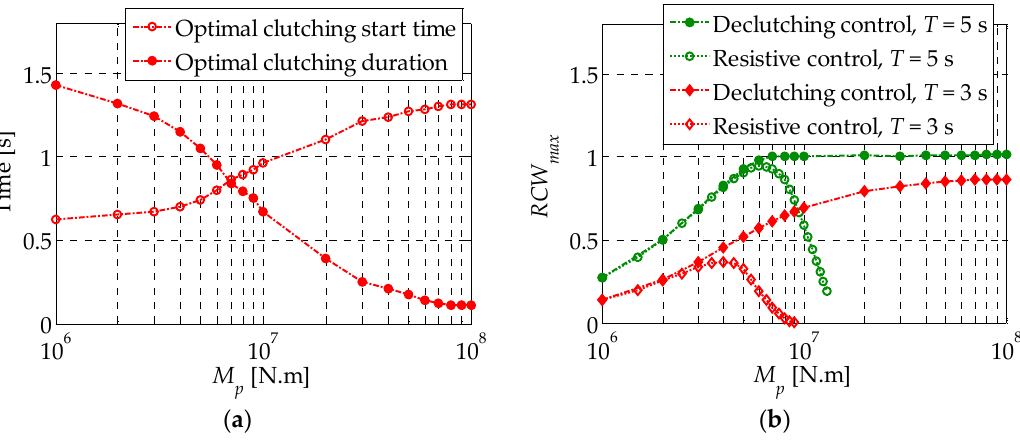
Figure 12. ( a ) Optimal clutching start time and clutching duration that maximize the relative capture width as functions of the PTO cylinder moment for the coulomb load at T = 3 s; ( b ) the maximum relative capture width as a function of the PTO cylinder moment for the coulomb load under different control methods.